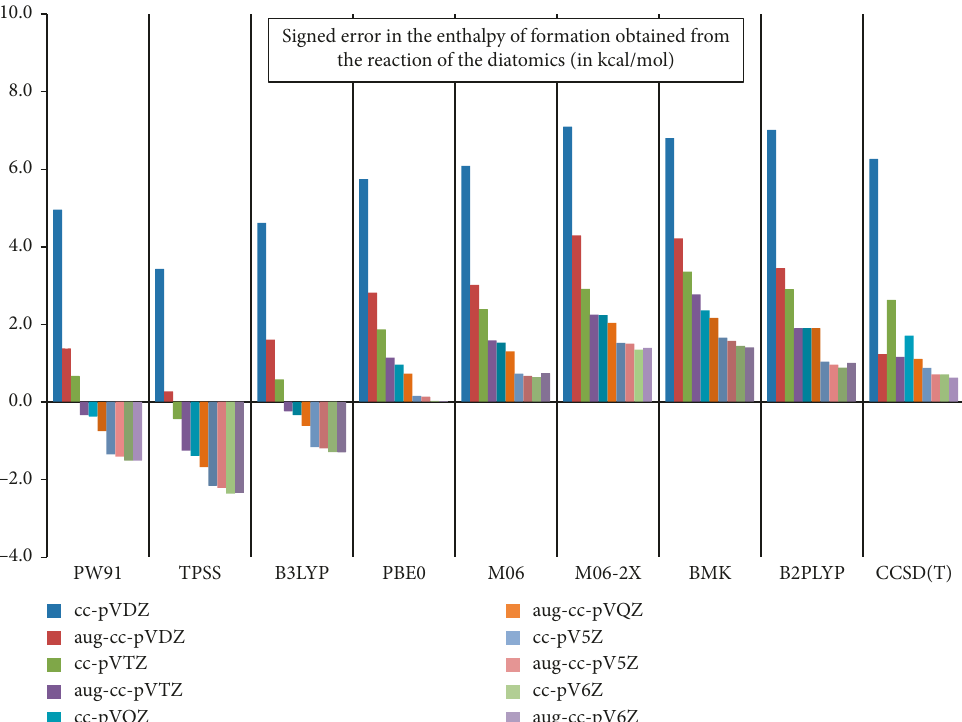
Figure 3: Difference between the enthalpy of formation of ClO at 298.15K obtained from the reaction of diatomic chlorine and oxygen, reaction (2), and the experimental value (in